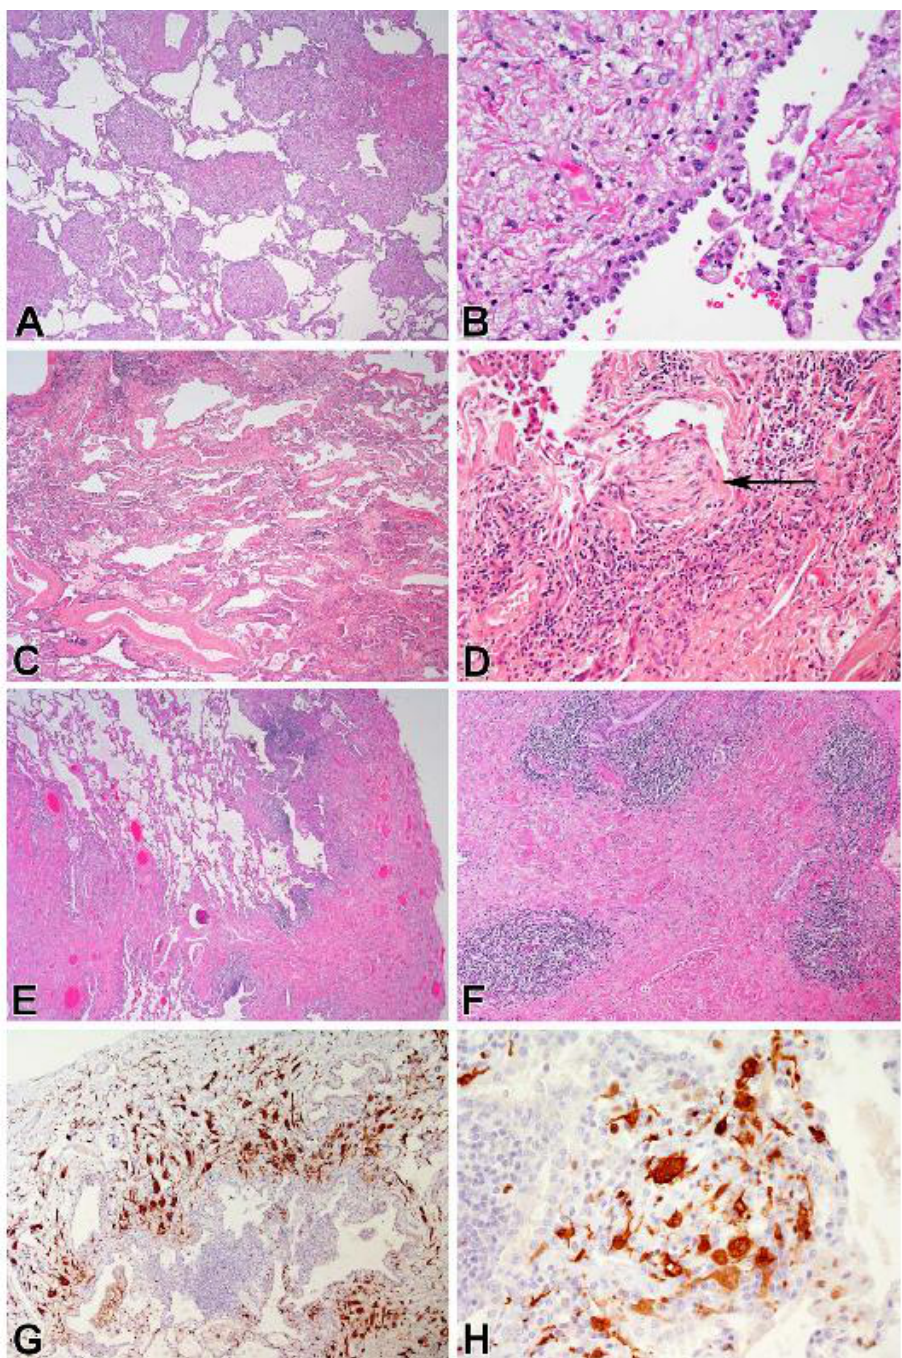
Figure 3. Representative pulmonary pathology images from a patient with Erdheim–Chester disease (ECD) show nodular areas of fibrosis with intervening normal alveolar parenchyma ( A ) (H&E, 40×) and type II pneumocyte hyperplasia overlying an area of fibrosis ( B ) (H&E, 400×). Photomicrographs of lung tissue from another ECD patient reveal diffuse interstitial fibrosis ( C ) (H&E, 40×) and a fibroblast focus (arrow) protruding from dense fibrosis with moderate lymphocytic inflammation ( D ) (H&E, 200×). Images from a third ECD patient demonstrate dense pleural and septal fibrosis with areas of normal alveolar parenchyma ( E ) (H&E, 40×), lymphoid aggregates within a region of dense fibrosis ( F ) (H&E, 100×), abnormal histiocytic infiltrate highlighted by immunostaining for factor XIIIa ( G ) (anti-factor XIIIa, 100×), and histocytes with abundant cytoplasm and slender cell processes ( H ) (anti-factor XIIIa, 400×).